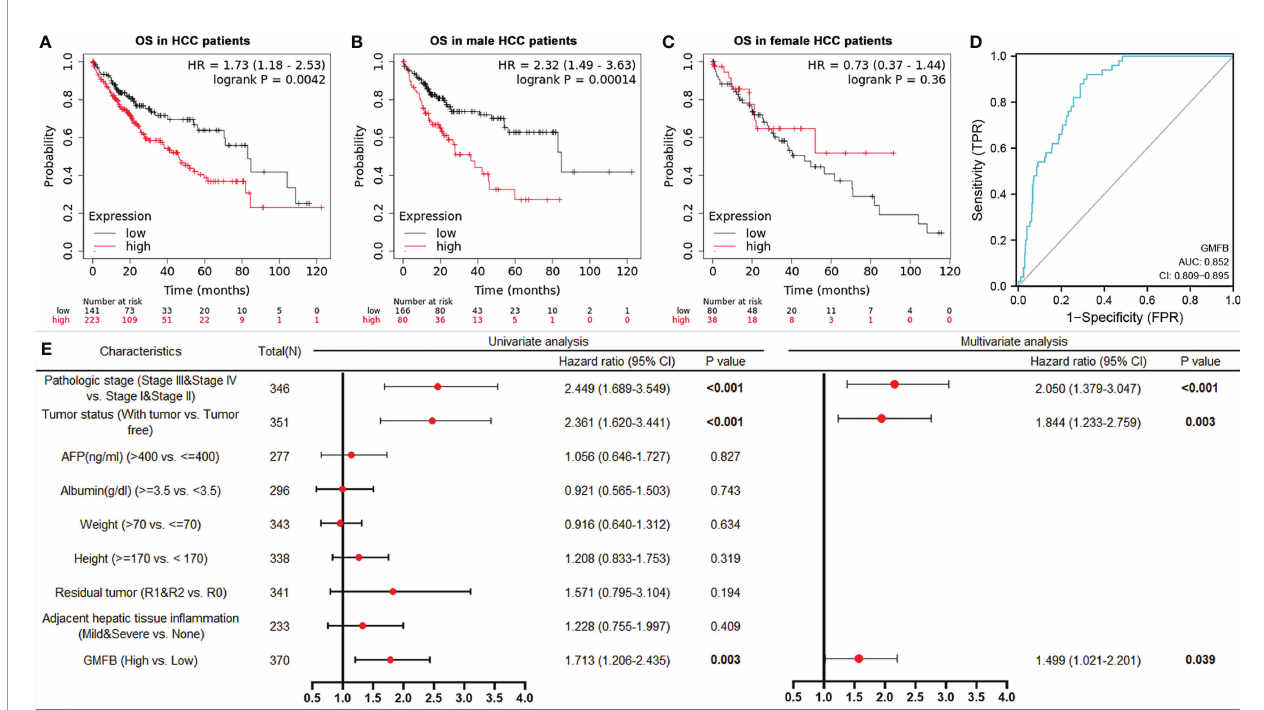
FIGURE 3 | Kaplan-Meier curves showed high mRNA expression levels of GMFB was associated with unfavorable overall survival (A) High expression of GMFB was associated with poor survive in HCC patients (KM plot). Kaplan – Meier survival estimation for male (B) and female (C) HCC patients (KM plot). OS, Overall survival. (D) The receiver operating characteristics (ROC) curves for prediction of GMFB expression in patients with hepatocellular carcinomas vs. controls. ROC curves of the radiomics signature, clinical model, and combined model in HCC cohorts (E) Univariate and multivariate Cox analysis of the overall survival (OS) by proportional hazard analysis for cancer-speci fi c survival in HCC patients. The red circle indicated the HR, and the transverse lines indicate the 95%